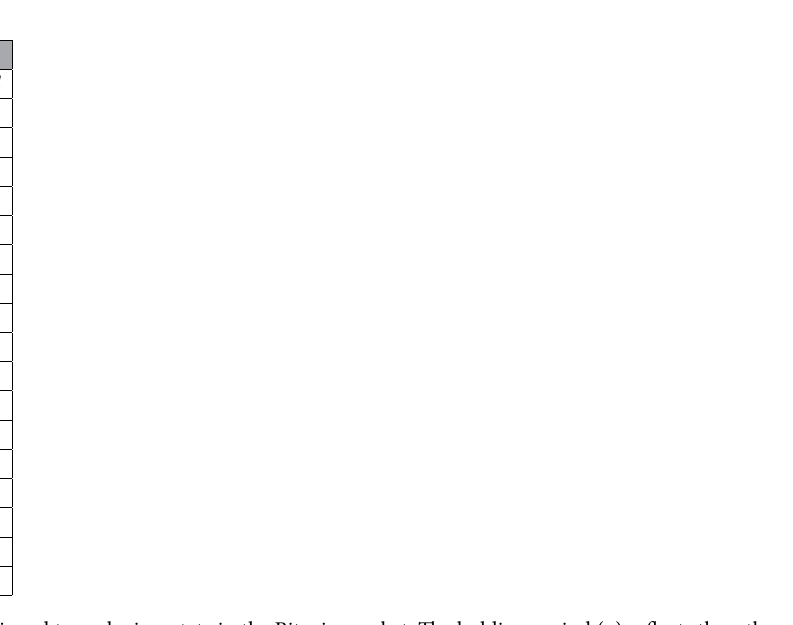
Table 7. Probability assigned to each eigenstate in the Bitcoin market. The holding period ( q ) reflects the q th difference of the log price data as x t